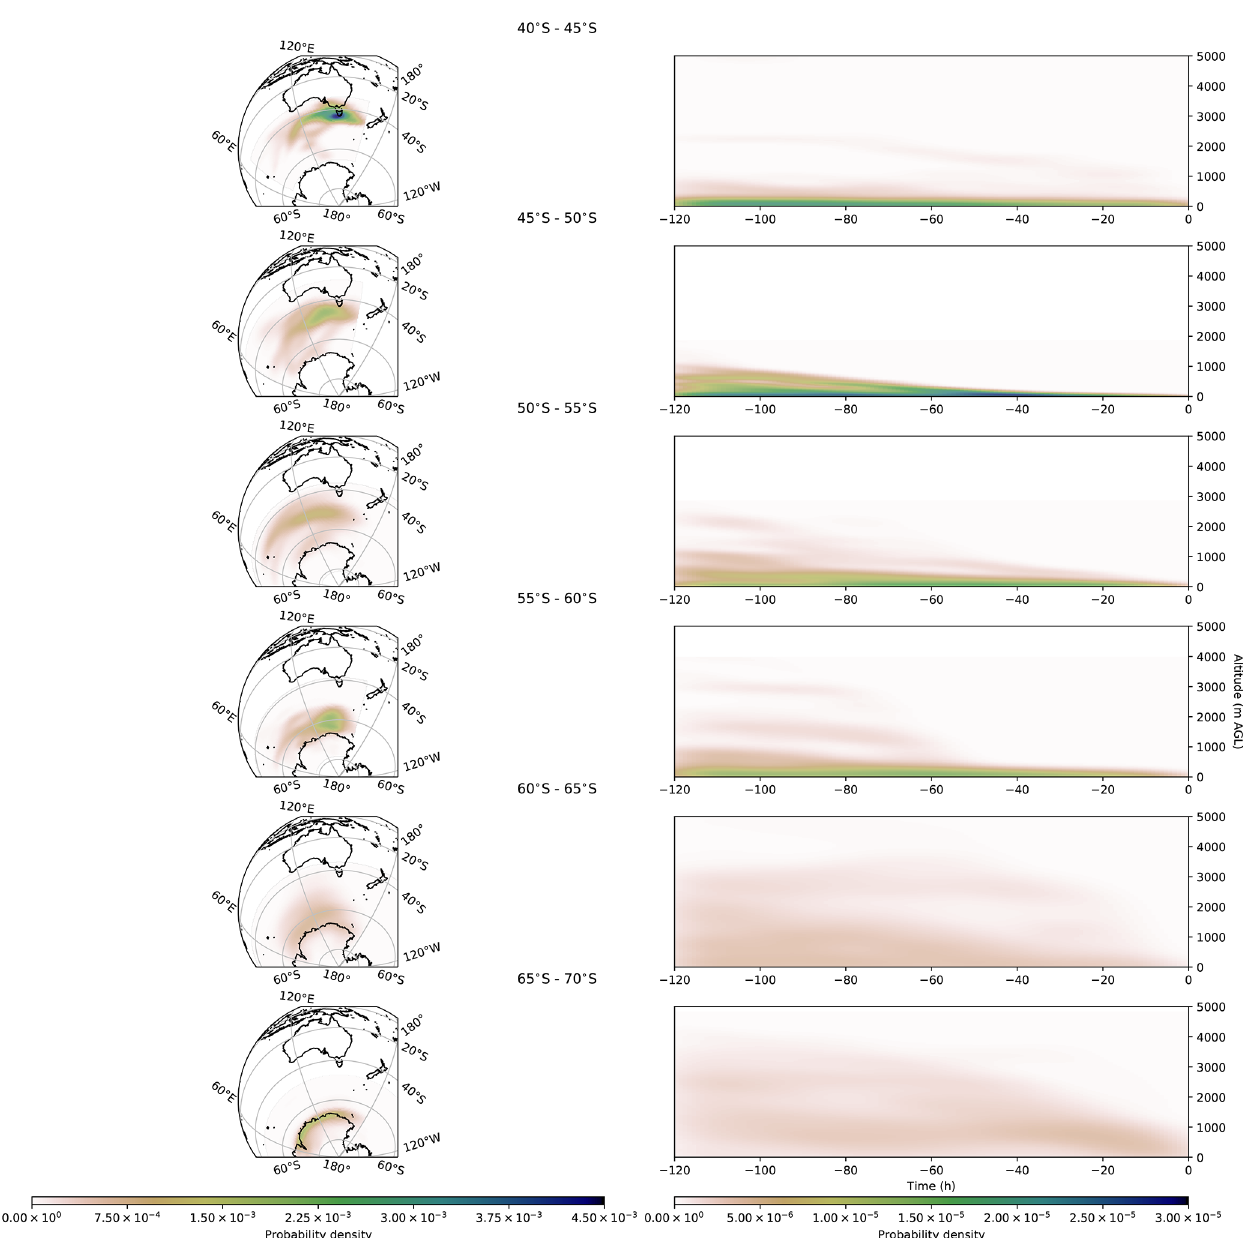
Figure 4. Trajectory frequency plots showing the spatial footprint of measurements in each latitudinal bin in each dimension. Five-day backward trajectories were calculated for each hour of valid, exhaust-free data, and then the number of times trajectories passed through 0.5 ◦ bins was summed before smoothing, resulting in frequency plots. Map plots are shown in the left column, with the starting locations of each of the trajectories used for each binned plot shown in black. The right column shows the frequency plots as a function of time and altitude, giving an indication of the dominant atmospheric layers important in each